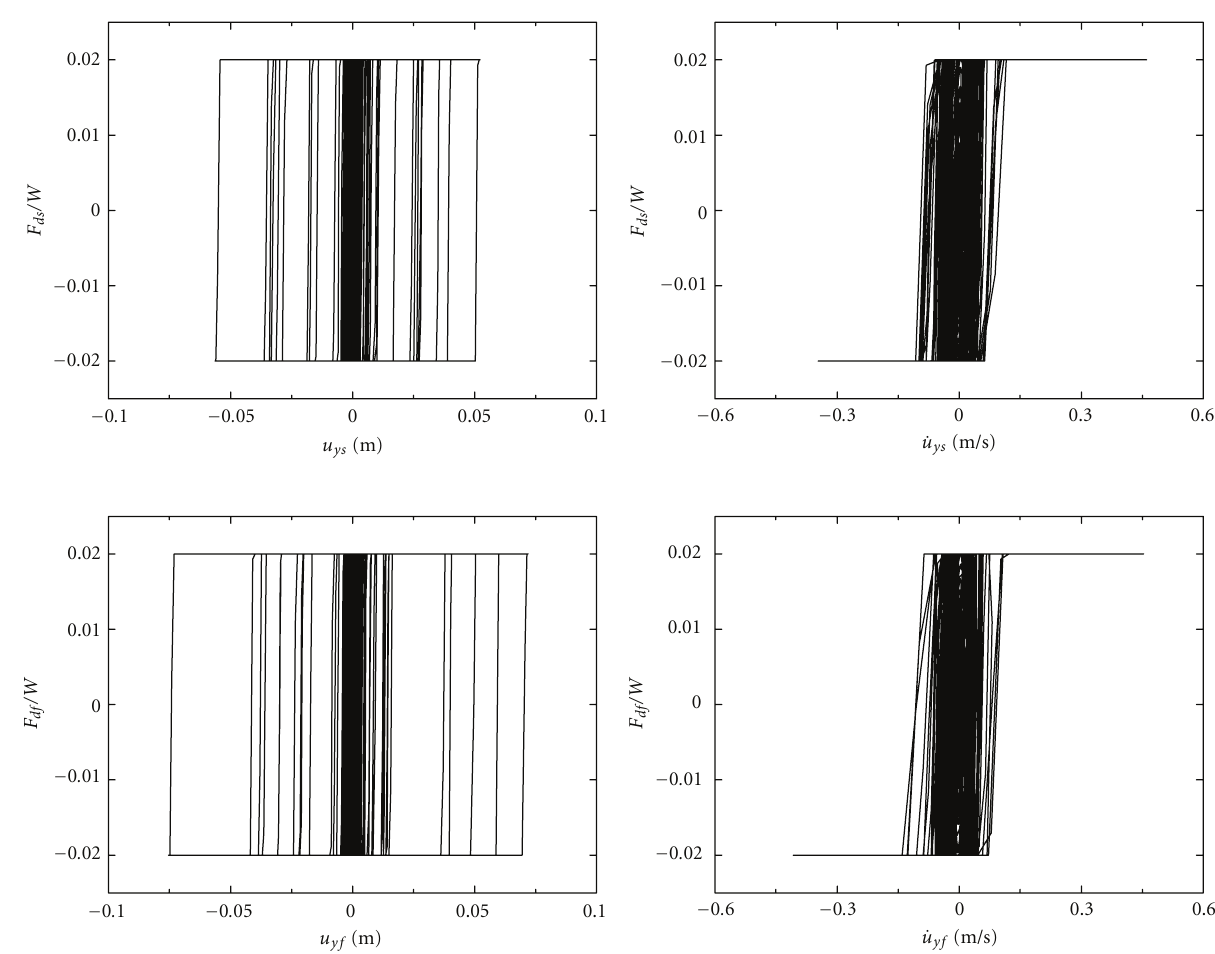
Figure 7: Normalized damper force-displacement and velocity loops for dampers located at sti ff and flexible edges for passive-on algorithm under Imperial Valley, 1940 earthquake ( T y = 1s, Ω θ = 1, e x / r = 0 .